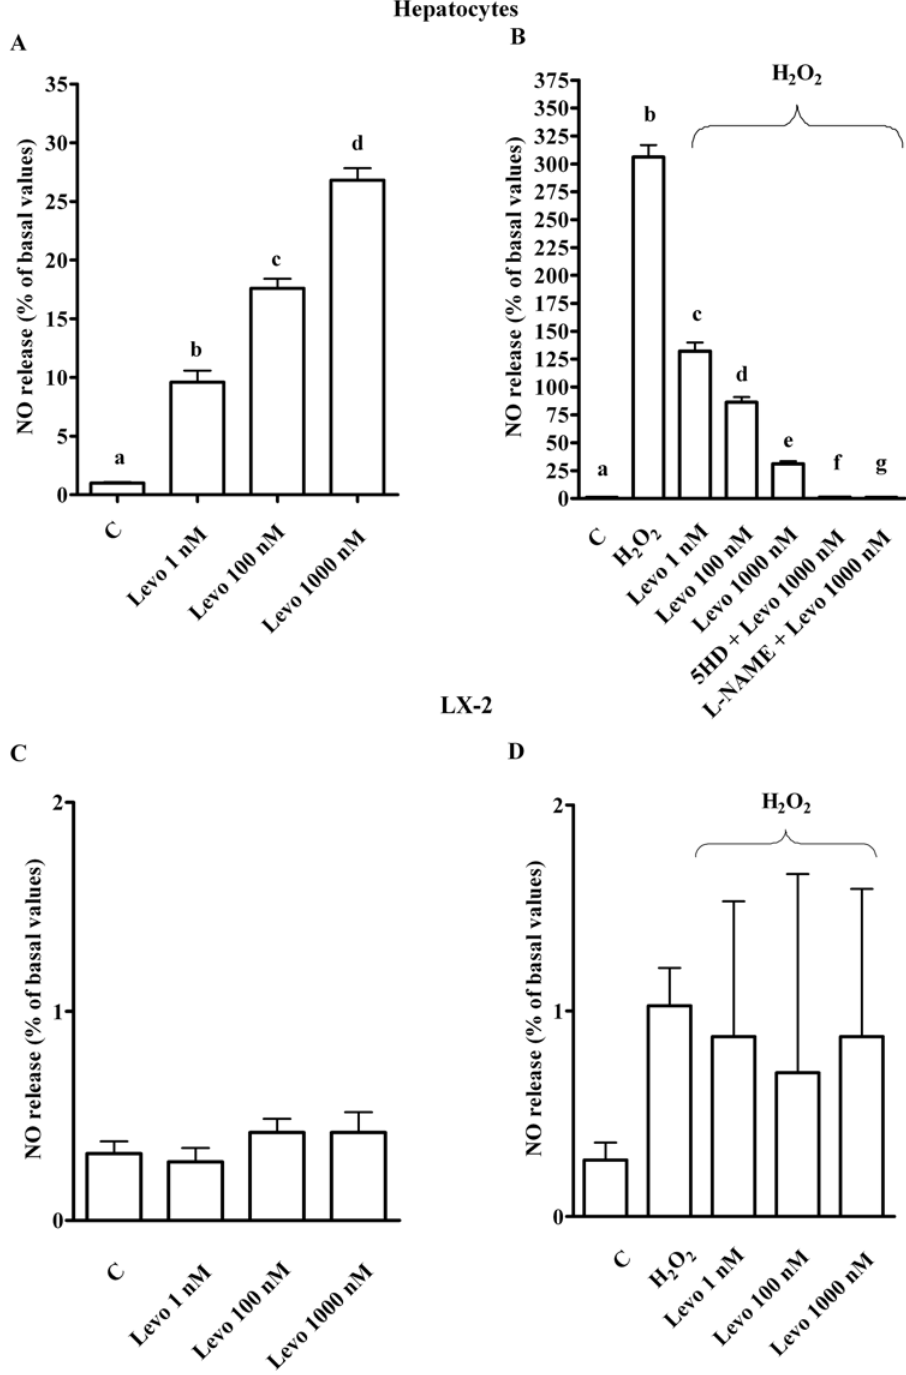
Fig 4. Effects of levosimendan on nitric oxide release in hepatocytes and LX-2. In A, hepatocytes in physiological condition. b, c, d P < 0.05 vs a; c, d P < 0.05 vs b; d P < 0.05 vs c. In B and C, hepatocytes in peroxidative conditions. b, c, d, e P < 0.05 vs a; c, d, e, f, g P < 0.05 vs b; d, e P < 0.05 vs c; d, f, g P < 0.05 vs e. In C and D, in LX-2. NO = nitric oxide. Other abbreviations are as in Figs 1 – 3. The results obtained in hepatocytes and LX-2 are expressed as means of 5 and 4 independent experiments (%) ± SD (indicated by the bars), respectively.